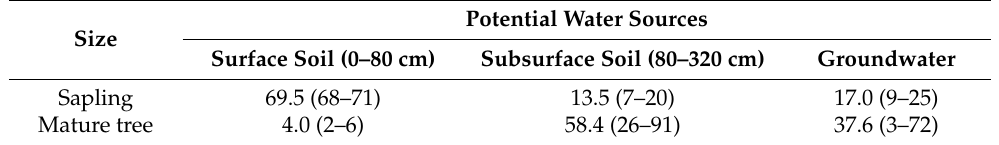
Table 1. Estimated proportion of water source use (%) in Populus euphratica .